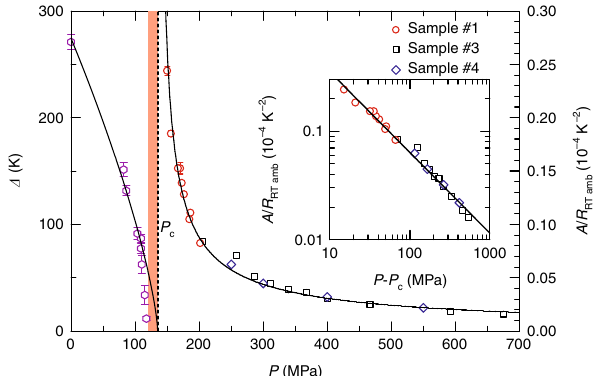
Fig. 3 Pressure dependence of the charge gap and the T 2 coef fi cient of resistance. The charge gap Δ was deduced from the line fi tting to the data of 2d(ln R )/d(1/ T ) at low temperatures, and the error of the fi tting constant is also indicated (see Supplementary Note 6 and Supplementary Fig. 9 for details). The solid lines indicate the fi tting curves of Δ ∝ | P − P c | 0.73 ± 0.04 and A ∝ | P − P | − 0.75 ± 0.01 P T 2 coef fi cient A is normalized c , where c is 135MPa. The by resistance at room temperature under ambient pressure, R RT,amb , for each sample. The charge gap is almost closed in the orange-coloured pressure region. The inset shows a log – log plot of A / R RT,amb vs. P − P